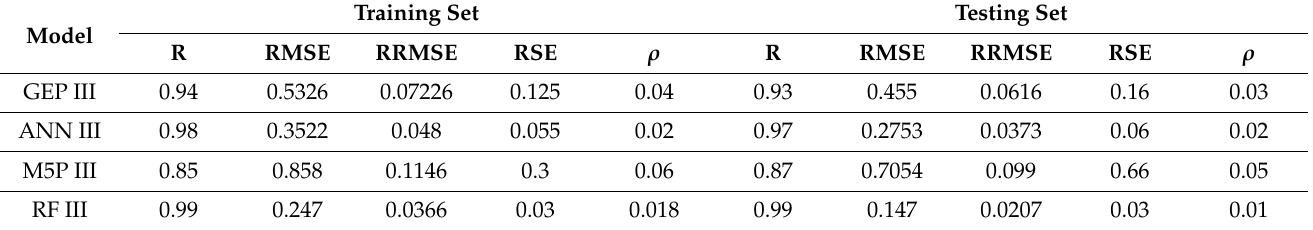
Figure 22. Experimental and predicted values of FS by RF III for ( a ) training set and ( b ) testing set, and their corresponding absolute error for ( c ) training data set and ( d ) testing data set. Table 7. Statistical evaluation of GEP III, ANN III, M5P III, and RF III.